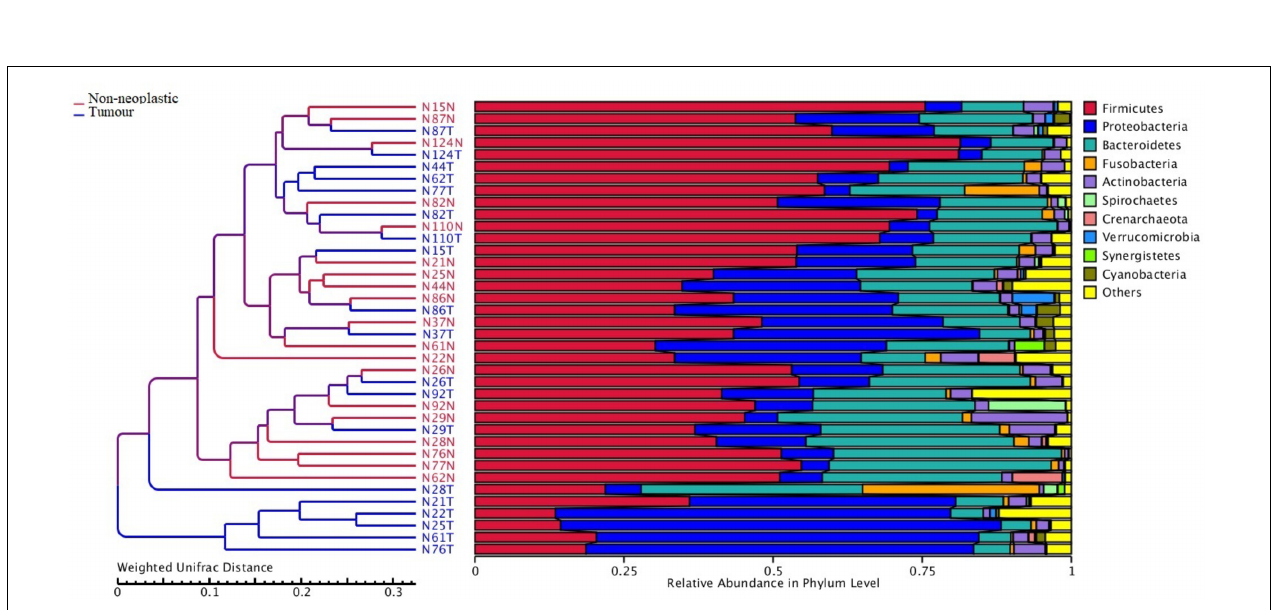
FIGURE 3 | Unweighted pair group method with arithmetic mean (UPGMA) based on weighted UniFrac distances.